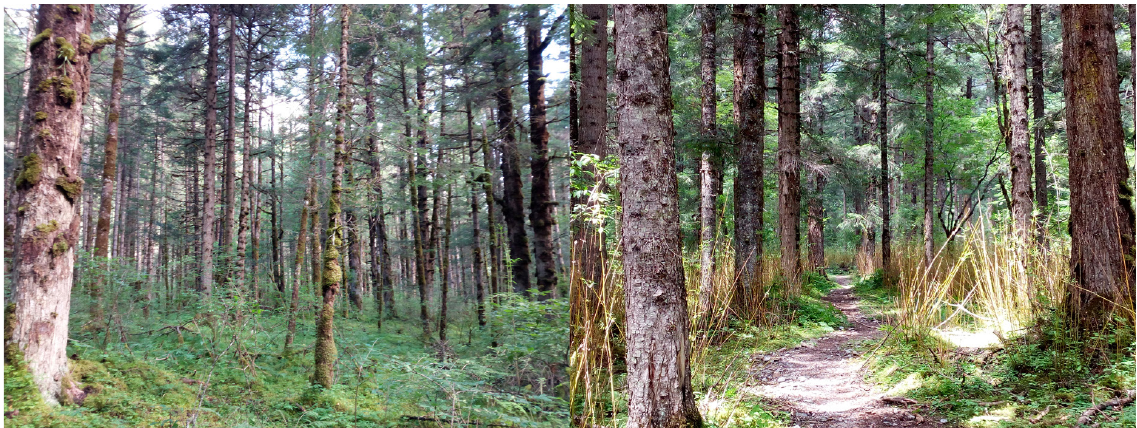
Fig. 24. The ecological environment of Biema wanglangensis Huo & Zhao gen. et sp. nov. collection area in